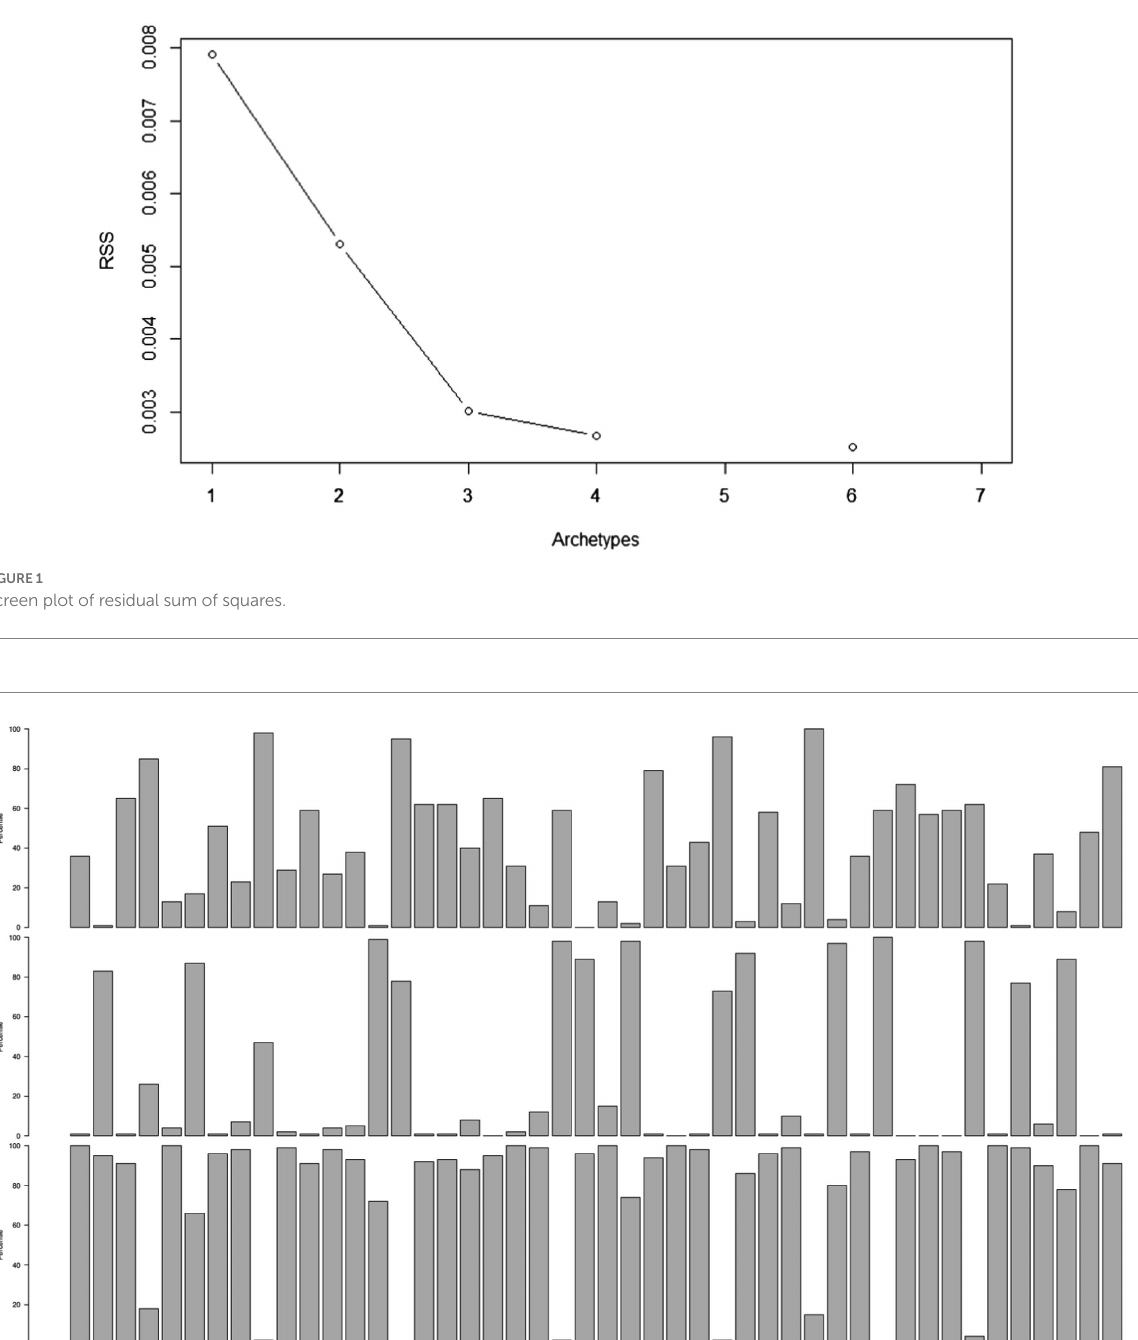
FIGURE 2 Behavioral score distributions for the three